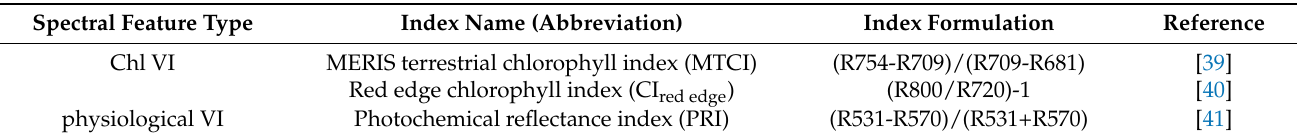
Table 2. Vegetation indices and formulas used in the